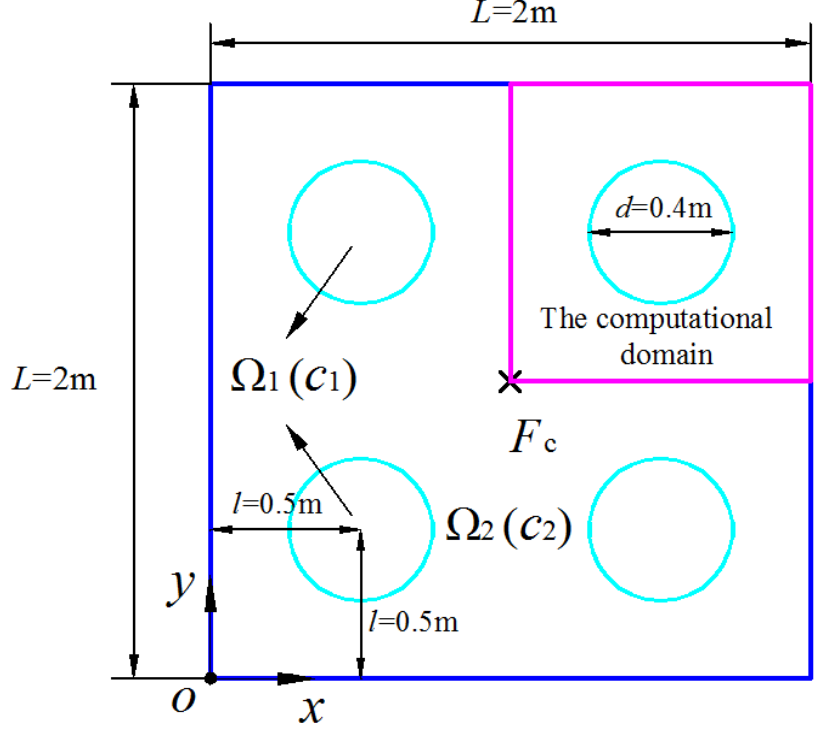
Figure 13. The geometry description of the two‑dimensional acoustic wave scattering problem. ◦ For the wave travel angle of θ = 45 and the non‑dimensional time integration size CFL = 0.1, the transient responses of the acoustic pressure distributions at two different time points ( t = 0.4 s and t = 0.7 s) are first computed by using different numerical ap‑ proaches, and the corresponding results are plotted in Figures 14 and 15. In Figure 15, both reflected and transmitted acoustic waves are induced by the interface of different acoustic fluid media; the positions of the interface are also given in Figure 15 using pink lines. The results provided by these figures show that the FEM‑Q4 solutions are obviously worse than the meshfree RPIM ones, which match very well with the reference solutions, while the FEM‑Q4 solutions obviously deviate quite substantially from the reference solu‑ tions. Additionally, the related numerical computations are further performed by consid‑ ◦ ◦ ◦ ering the different wave travel angles ( θ = 0 , θ = 22.5 , and θ = 45 ). Figure 16 gives the obtained acoustic pressure distribution results from different numerical approaches.